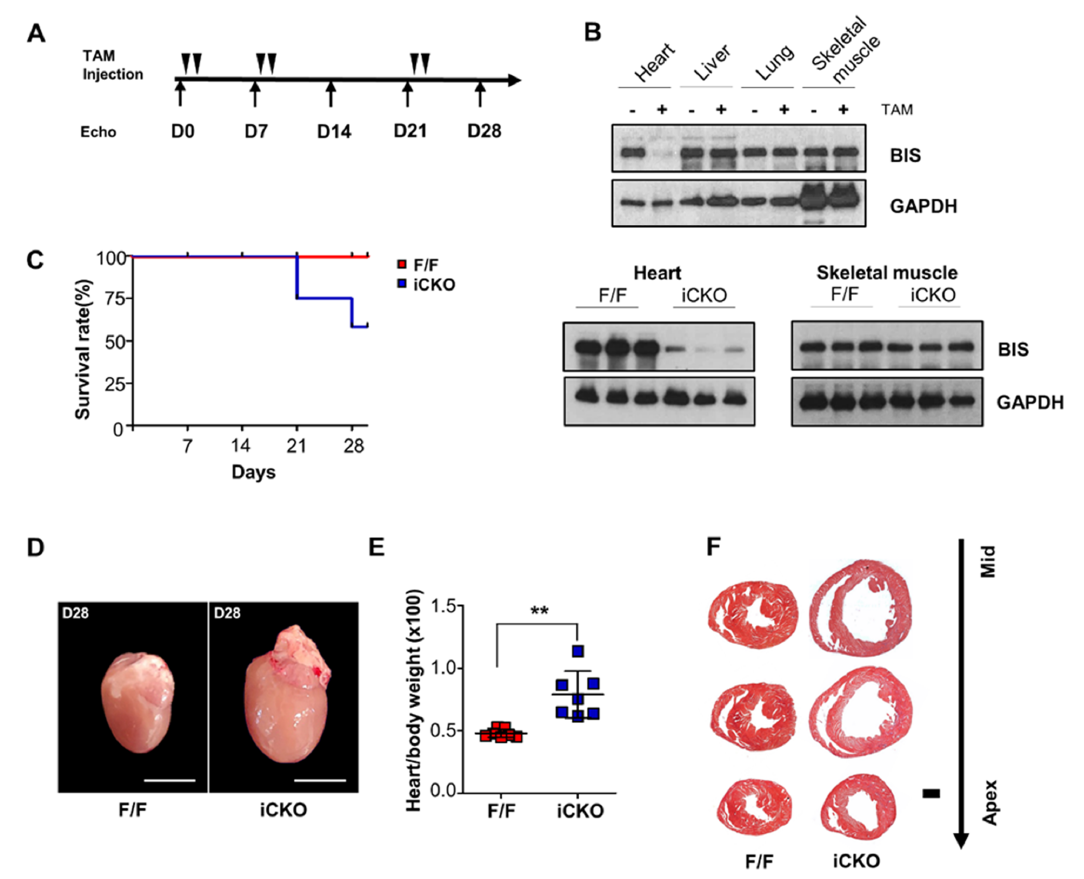
Figure 1. Cardiac specific depletion of BCL-2 interacting cell death suppressor (BIS) by α -MHC-MerCreMer strategy. ( A ) Scheme of tamoxifen (TAM) injection and echocardiography (Echo). ( B ) Western blot analysis of BIS expression in several tissues from double transgenic mice (Bis f/f : α -MHC-MerCreMer-positive) before and 28 days after tamoxifen injection (upper) and in the hearts and skeletal muscles from control (Bis f/f , F/F) and tamoxifen-inducible cardiomyocyte-specific BIS-KO (Bis-iCKO) (iCKO) mice 28 days after the first tamoxifen injection (lower). ( C ) Survival curves for F/F (red) and iCKO (blue) mice. Survival was analyzed every week after tamoxifen injection (n = 12 for both groups 6 males and 6 females). ( D ) Morphology of whole hearts from F/F and iCKO mice on day 28; scale bar, 2 mm. ( E ) Heart weight to body weight ratio for F/F and iCKO mice was determined 28 days after the first tamoxifen injection (n = 7 for both groups, 4 males and 3 females). Data are presented as the mean ± standard deviation (SD). ** p < 0.01. ( F ) Hematoxylin and eosin staining of serial sections of the hearts from F/F and iCKO mice 28 days after tamoxifen injections; scale bar, 1 mm.